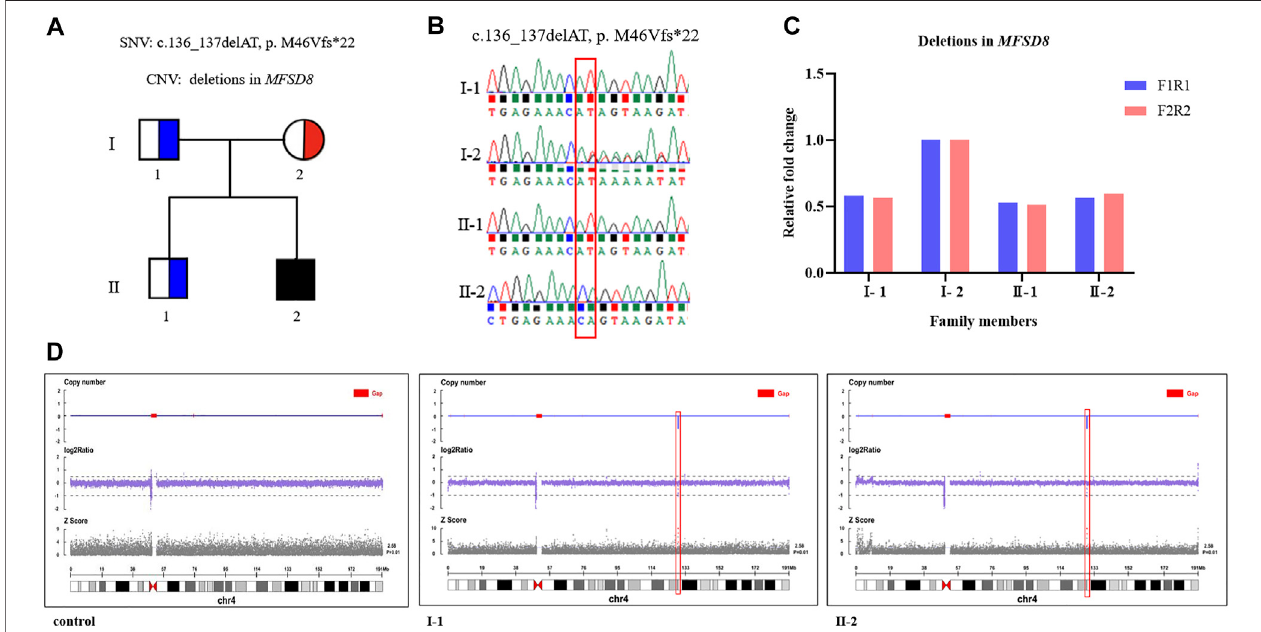
FIGURE 2 | Compound heterozygous variants were identi fi ed by WES and CNV-seq. (A) A Chinese family with CLN7 and MFSD8 mutations. The black fi lled-in square represents the proband (c.136_137delAT, p. M46Vfs*22, and whole MFSD8 deletion), the blue half- fi lled squares represent the heterozygous carriers of the MFSD8 deletions, and the red half- fi lled circle represents the heterozygous carrier of a novel two-nucleotide deletion (c.136_137delAT, p. M46Vfs*22). (B) Sanger sequencing validated the c.136_137delAT (p. M46Vfs*22) variant in the family. (C) Deletions in MFSD8 were con fi rmed by qPCR. (D) CNV-seq detected an ~130 kb deletion at 4q28.2 in both the father and